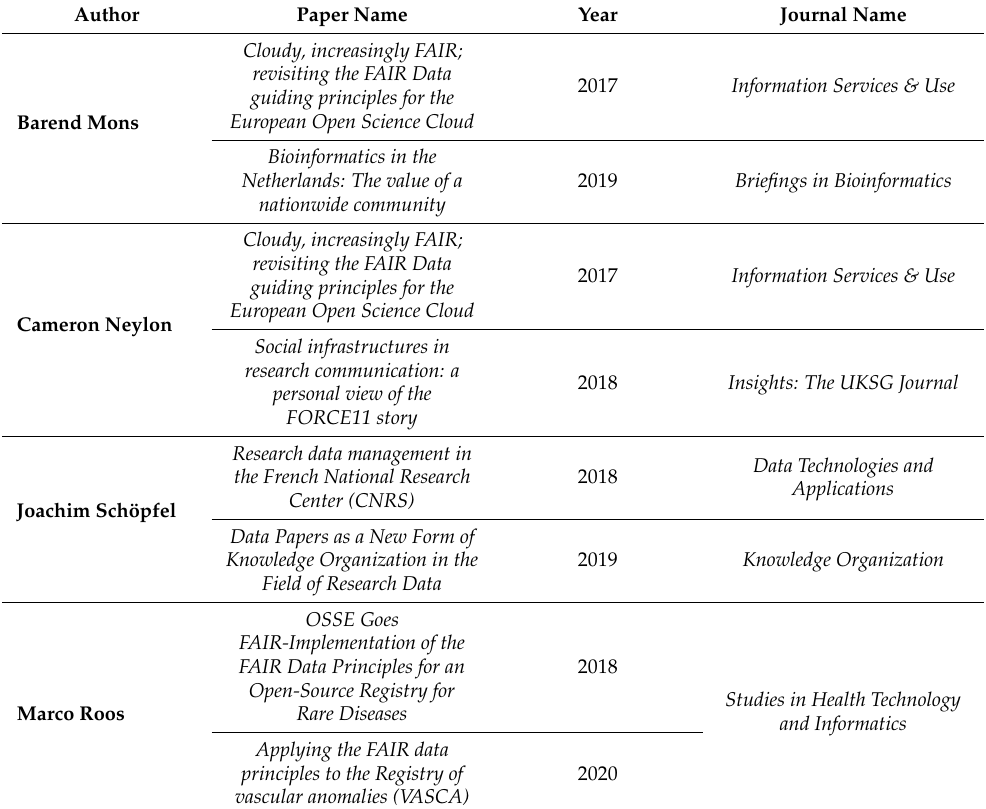
Table 3. Authors with more than one paper in the used